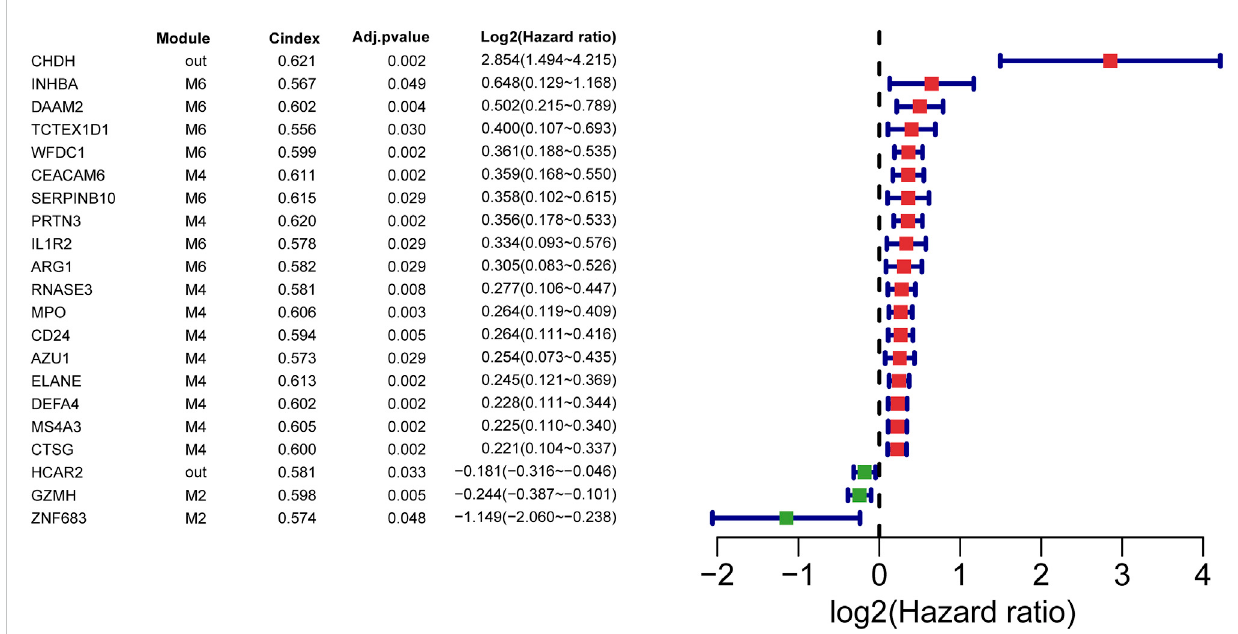
FIGURE 4 PrognosticSSAGs.TheforestplotsofprognosticSSAGswithadjusted p -valuelessthan0.05byunivariatecoxanalysisintheGSE65682dataset.Red forest plots represent risky factors and green forest plots represent protective